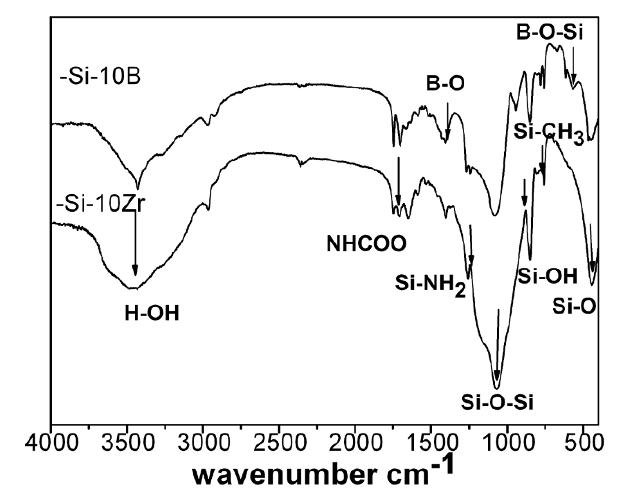
Figure 2. IR spectra of nanostructured hybrid materials Si-10B and Si-10Zr.